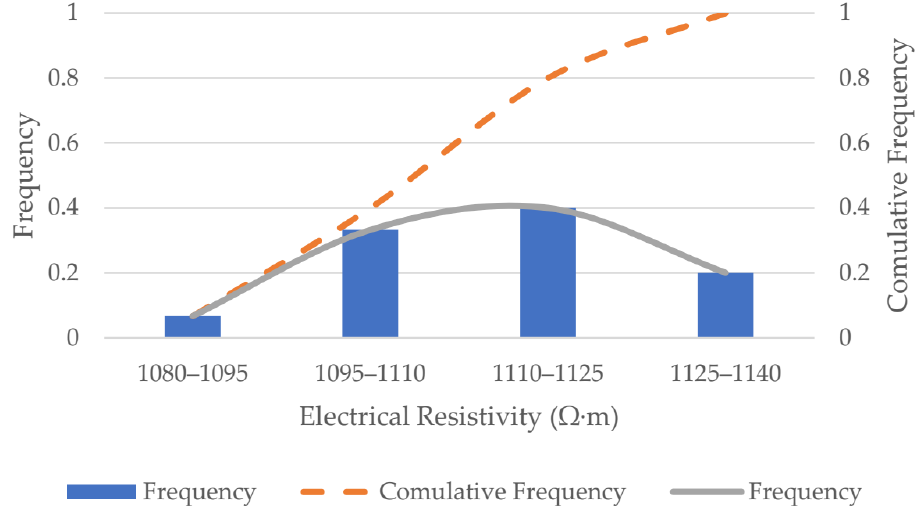
Figure 4. The normal distribution of electric resistivity values for various fiber dispersions, after [46].